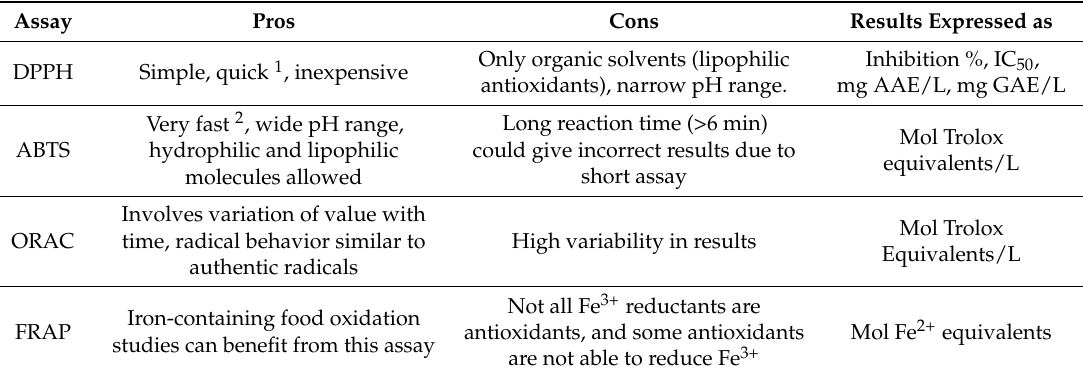
Table 2. Advantages and disadvantages of the most used scavenging assays and their typical units